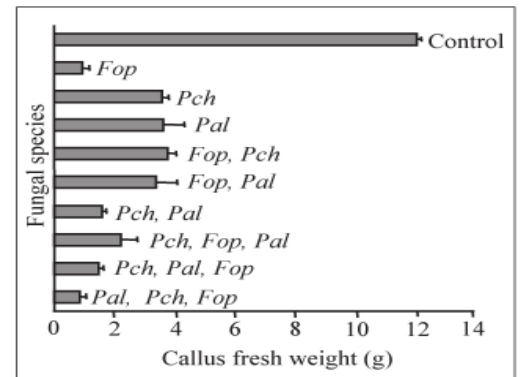
Fig. 3. Effect of Fomitiporia punctata ( Fop ), Phaeomon- iella chlamydospora ( Pch ) and Phaeoacremonium ale- ophilum ( Pal ) or their combinations on the yield of grape- vine cv. Italia calli. Standard error bars are shown.